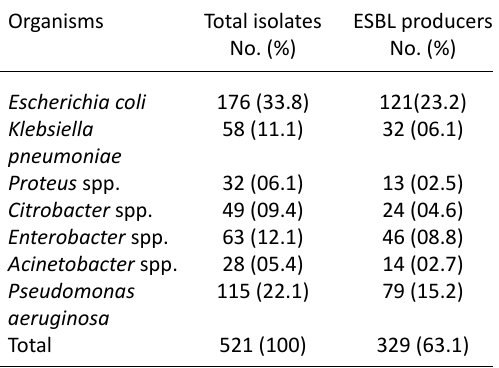
Table 1. Organisms isolated from various samples Organisms